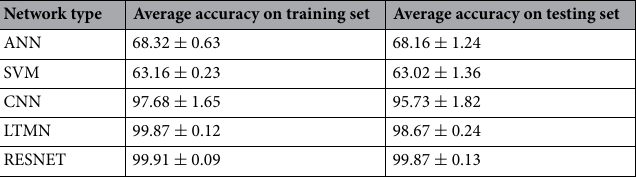
Table 3. Actuator fault type